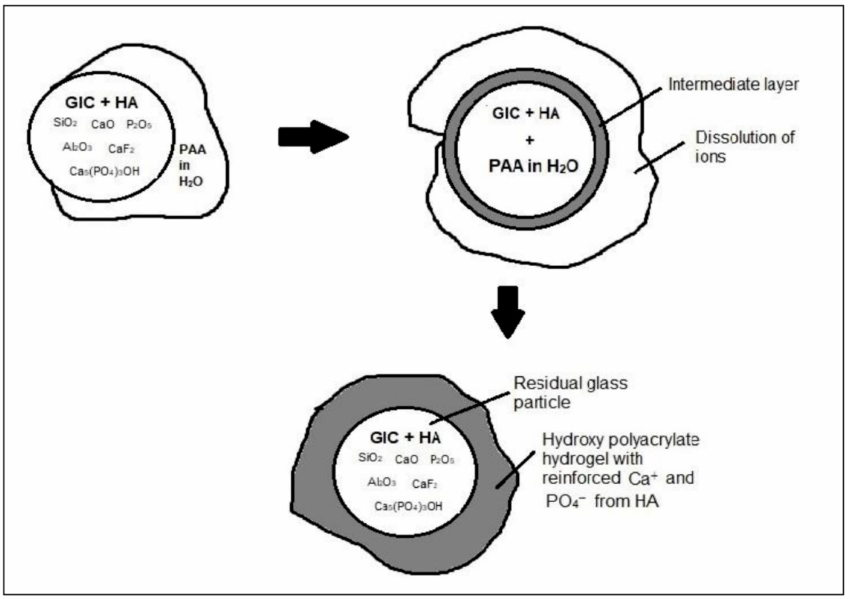
Figure 6. Schematic diagram of setting reaction of HA-added